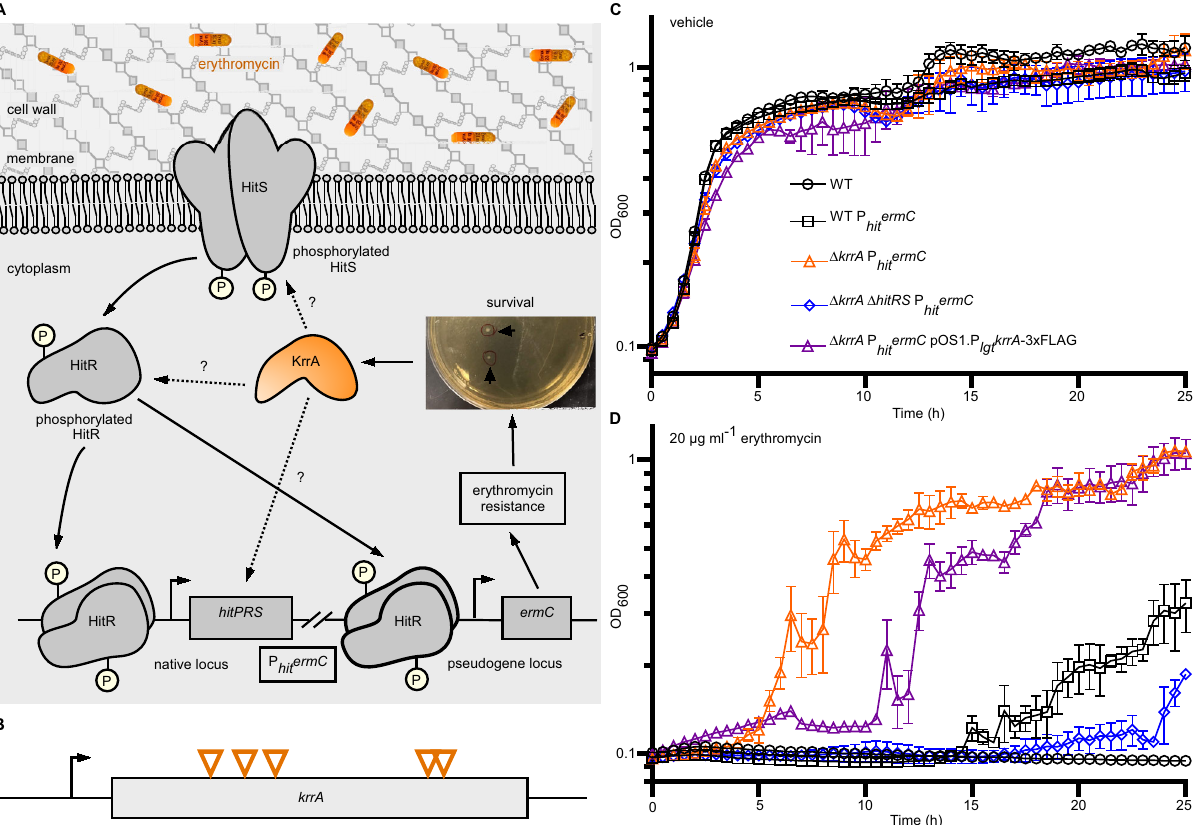
Fig. 1 An unbiased genetic selection strategy identi fi es KrrA as a regulatory factor in HitRS signaling. A Schematic of the genetic selection strategy: a strain containing ermC driven by a HitR promoter (P hit ermC ) was plated on medium containing toxic levels of erythromycin and colonies that arose represented bacteria that acquired mutations that constitutively activate the P hit promoter. B All 21 erythromycin-resistant suppressors isolated from genetic selections exhibit frameshift mutations at fi ve different positions within krrA . C , D Growth kinetics of B. anthracis WT, WT P hit ermC , Δ krrA P hit ermC , Δ krrA Δ hitRS P Δ krrA P µ g ml -1 erythromycin ( D ) were monitored for hit ermC , and the complemented strain hit ermC pOS1.P lgt krrA -3xFLAG in vehicle ( C ) or 20 24 h. The experiments were conducted at least three times. Data shown are averages of three biological replicates (mean ±